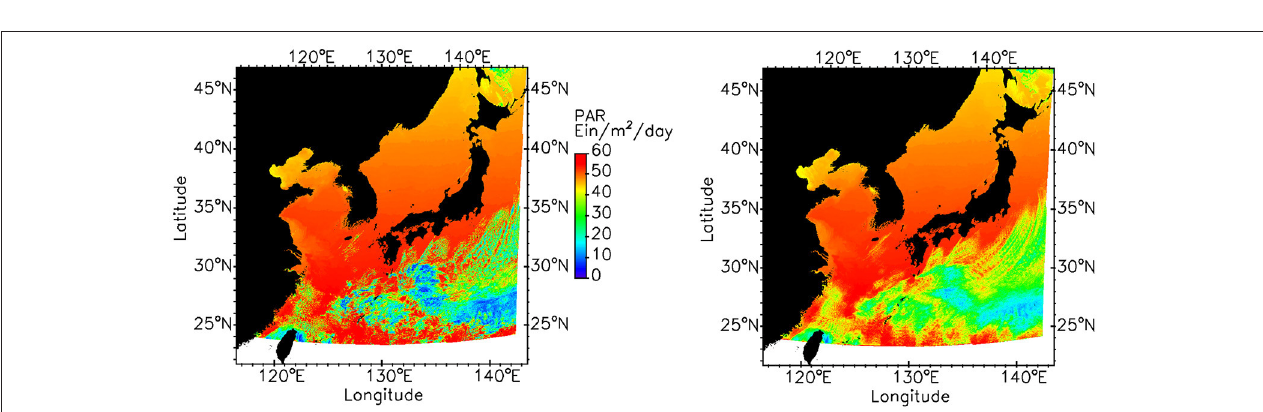
FIGURE 6 | Daily above-surface PAR distribution for April 5, 2011 obtained from 8 hourly GOCI observations during the day (right) and a single GOCI observation at 03:16 GMT (left) . In the stormy region South of Japan, the range of PAR values is smaller when using 8 observations due to diurnal changes in cloudiness. Reproduced with permission from Springer Nature (After Frouin and McPherson,